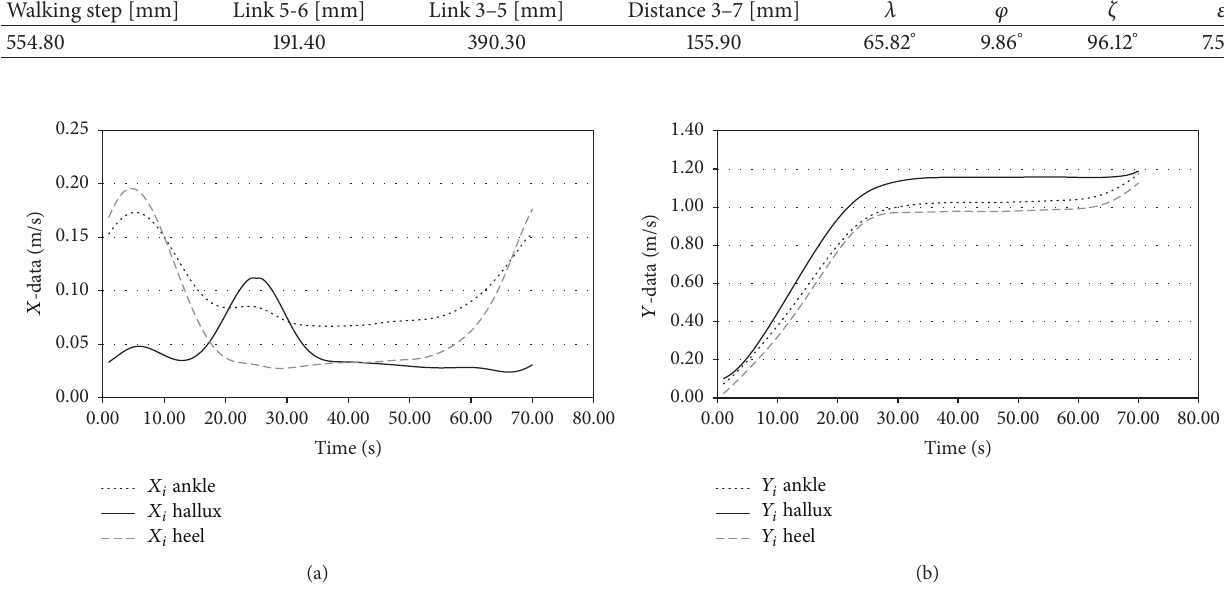
Figure 6: Trajectory in 𝑋 -plane (a) and 𝑌 -plane (b) during rehabilitation task.